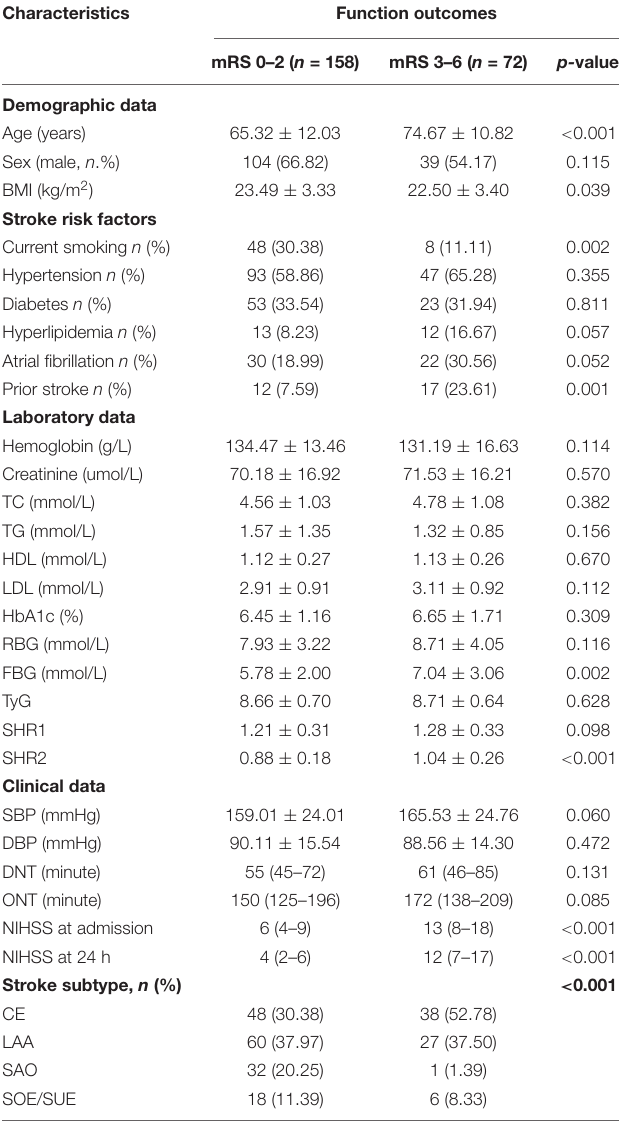
TABLE 1 | Characteristics of patients with AIS with good (mRS 0–2) vs. poor functional outcomes (mRS